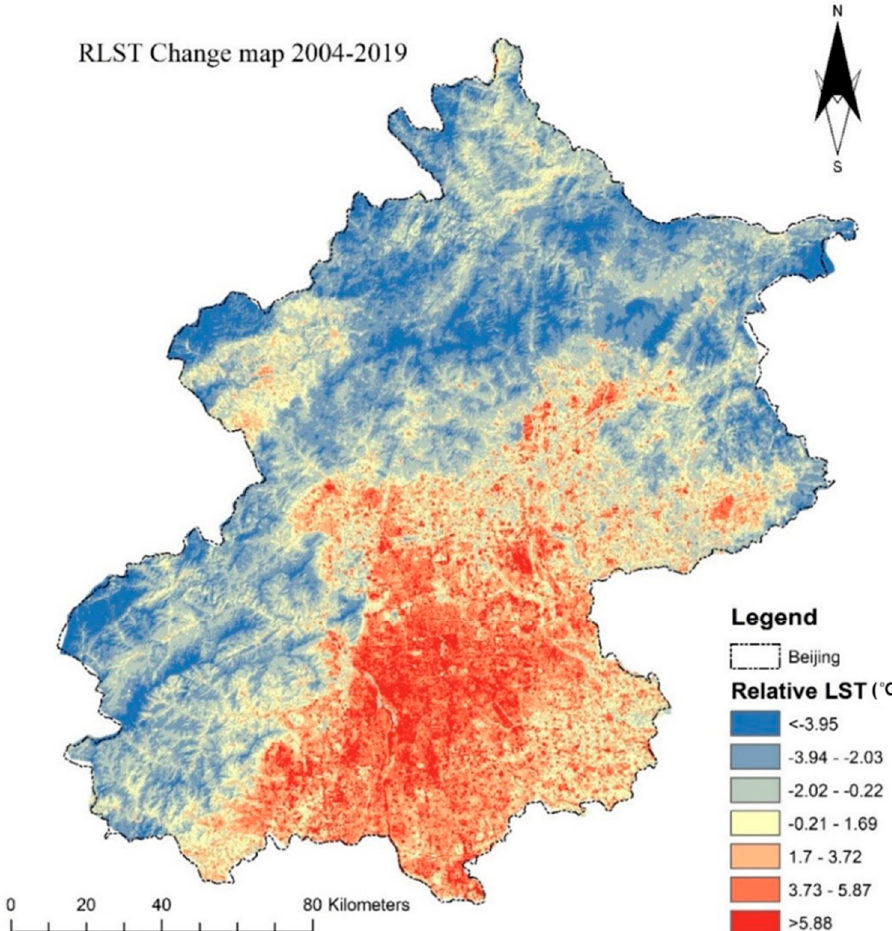
Figure 9. Relative land surface temperature (RLST) changes from 2004 to 2019. Table 7. The LUCC warming effect, percentage contribution in surface temperature, and standardized percentage contribu- tion (10%) of LUCC